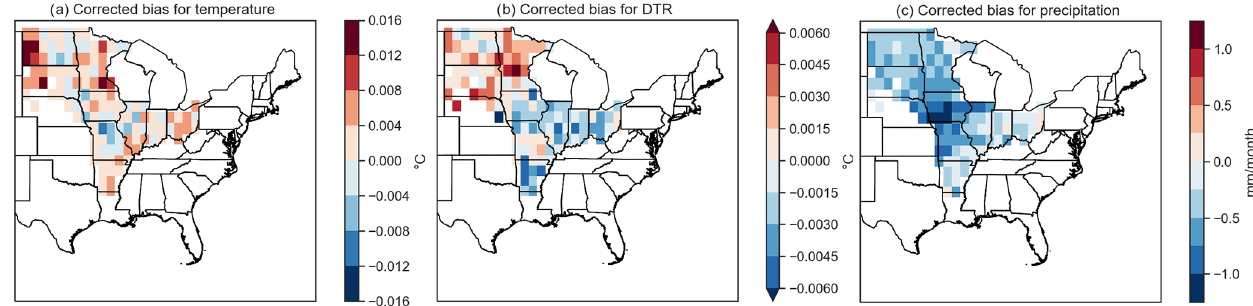
Figure C5. Spatial variability of bias-corrected values between observed data and EC-Earth PD scenario for (a) monthly temperature values, (b) DTR and (c) precipitation.